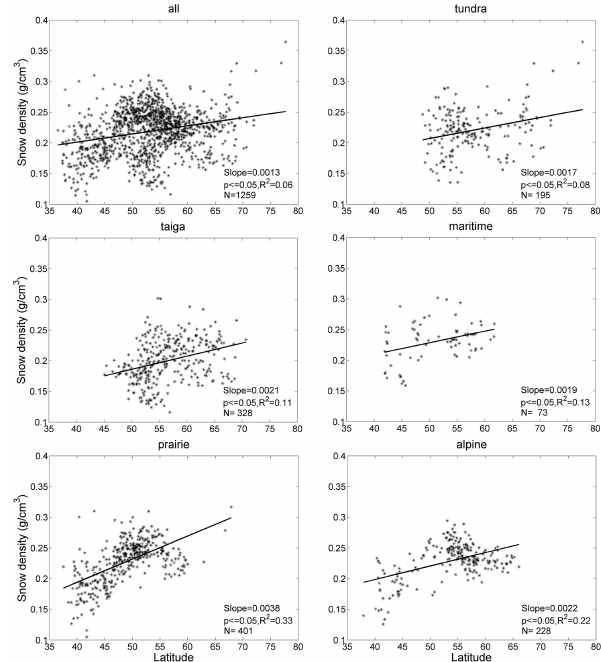
Fig. 15. Snow density changes with latitude. Asterisks show the mean snow density of each site; the thick line is a linear regression with the parameters shown on the upper-right corner, where Slope is the slope of 0.0013 in gcm − 3 per one degree, p is the confidence level for the coefficient estimates, R 2 is the goodness of fit coeffi- cient, and N is the number of